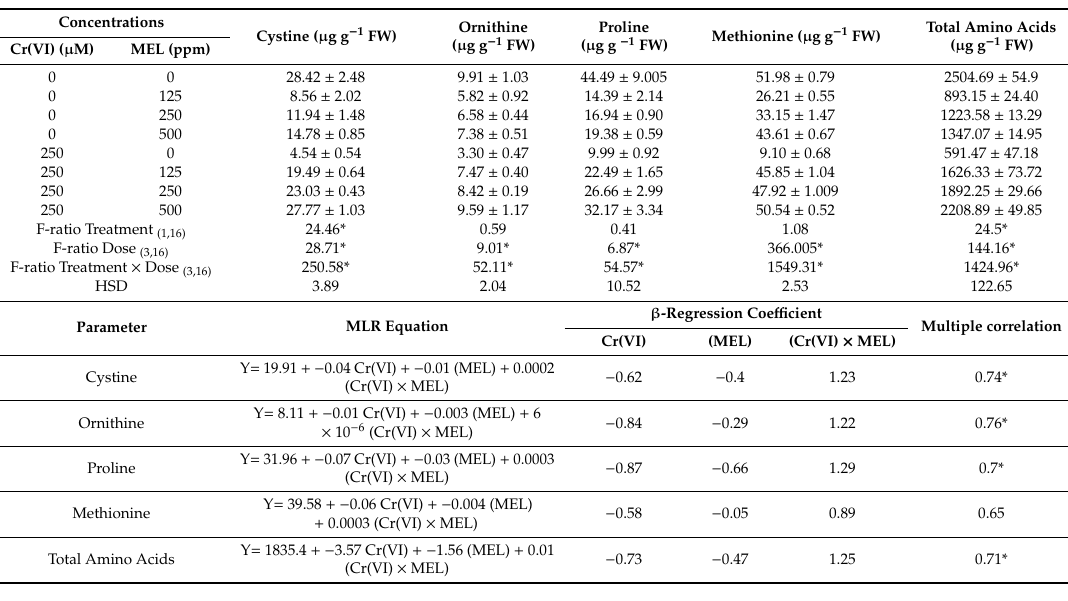
Table 11. E ff ect of Cr(VI), di ff erent concentrations of methanol extract of Rhododendron arboreum leaves (MEL), and their combinations on cystine, ornithine, proline, methionine, and total amino acid contents in 7-day-old Vigna radiata seedlings. The values are the means of three replicates ± SD. (standard deviation). Tukeys test performed and significance checked at * p ≤ 0.05. The F ratio is the term in which ANOVA is represented; Cr(VI) = Dose, MEL treatments = Treatment and combination of Cr(VI) and MEL = Dose ×